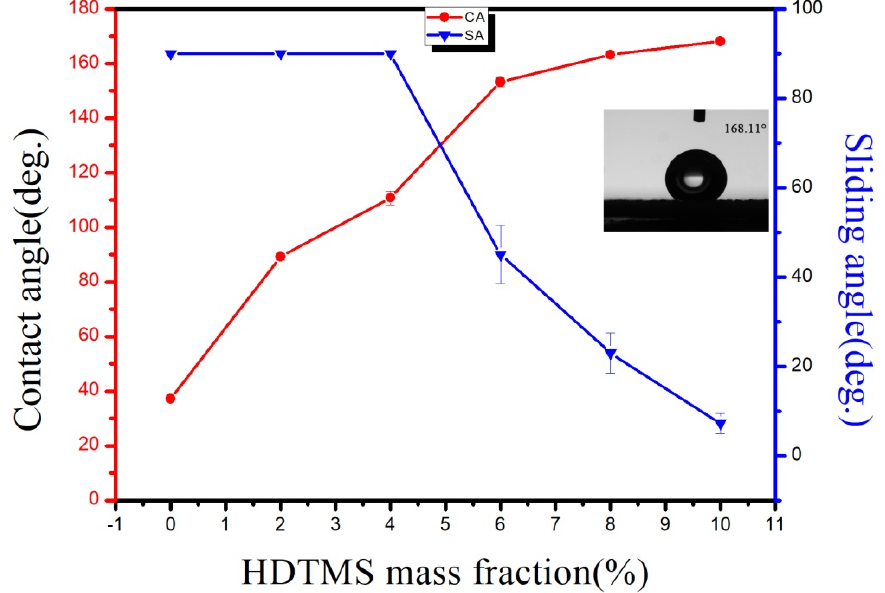
Figure 10. Wettability of samples modified with different mass fractions of HDTMS.